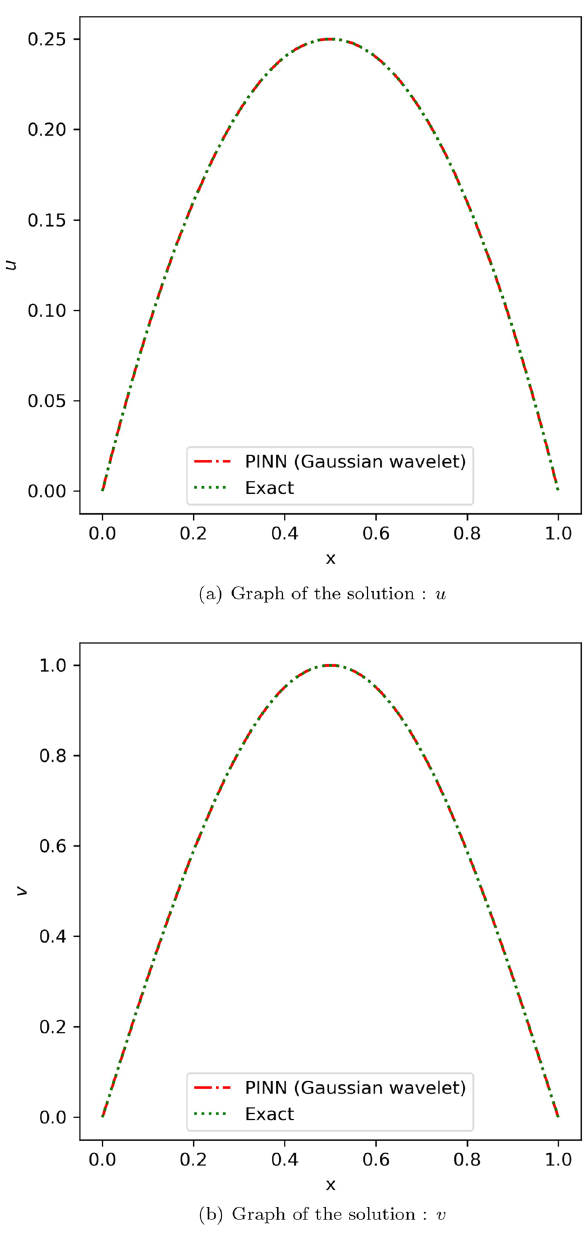
Figure 11. Comparison of the results of proposed method using Gaussian wavelet with the exact solution for the non-linear coupled equation.